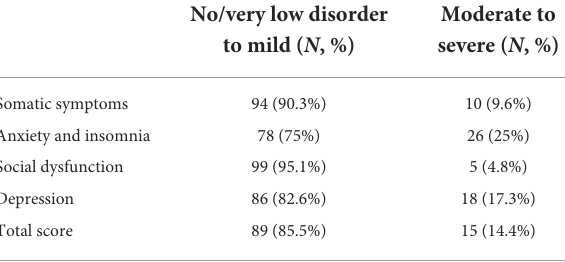
TABLE 1 Sociodemographic characteristics of the participants. Gender 62 (59.6%)